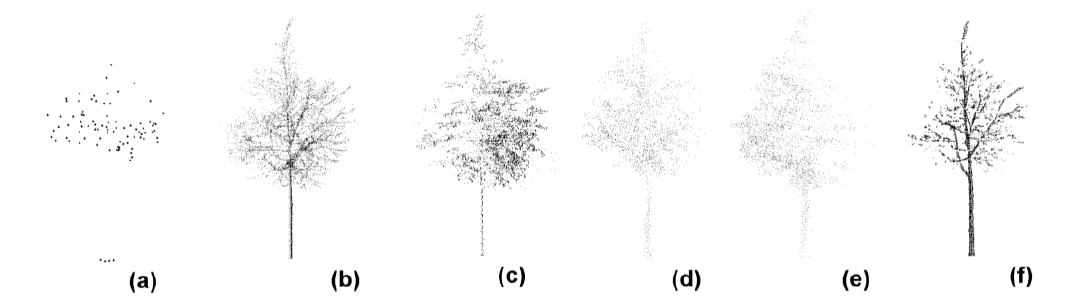
Figure 1. Illustration of the point clusters pertinent to a same tree that is surveyed by laser scanning in multi-modes: ( a ) ToA, ( b ) RiM, ( c ) RoM, ( d ) SeMM, ( e ) SeMJ, and ( f )